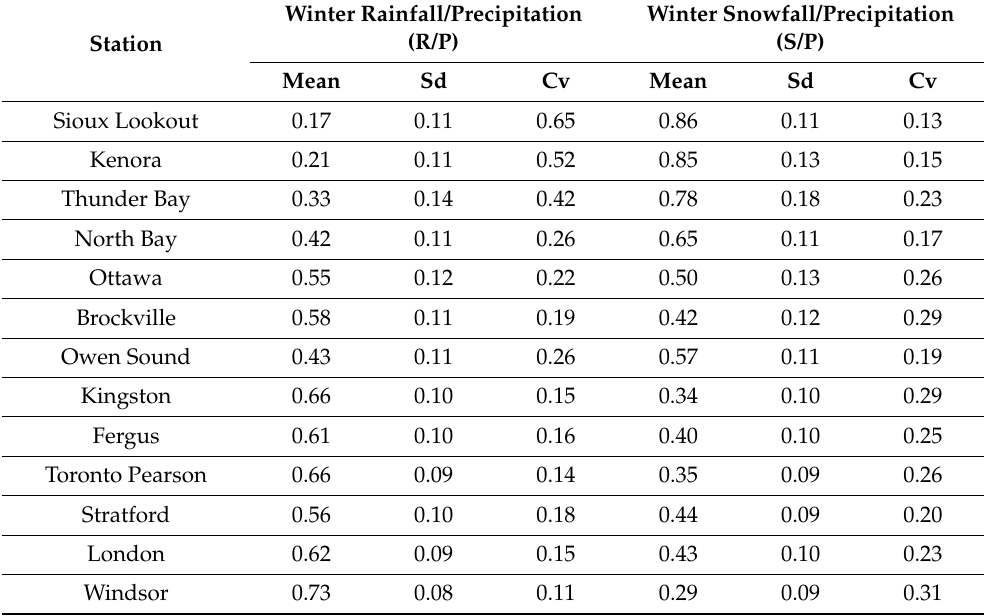
Table 8. Variability of ratio of rainfall to total precipitation (R/P) and snowfall to total precipitation (S/P) during